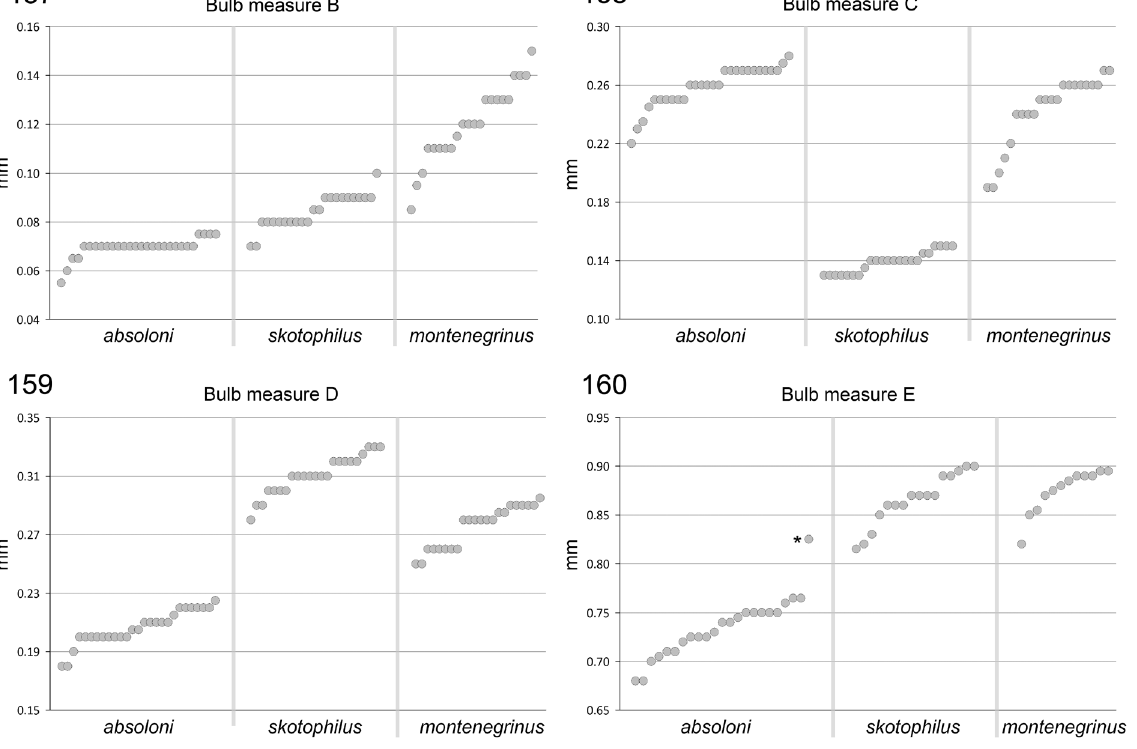
Figs 157–160. Bulbal measures B–E for the three species of the ‘northern clade’ of Stygopholcus Kratochvíl, 1932 (cf. Figs 15–18). Bulbal measure A is strongly correlated with measure C and therefore not shown. Bulbal measures sorted from smallest to biggest for each species of the ‘northern clade’. The bulb of S. photophilus was not measured (it differs strongly in shape, and measure D is inapplicable). Asterisk in Fig. 160 = dubious specimen from Jama na Brezdanu (see